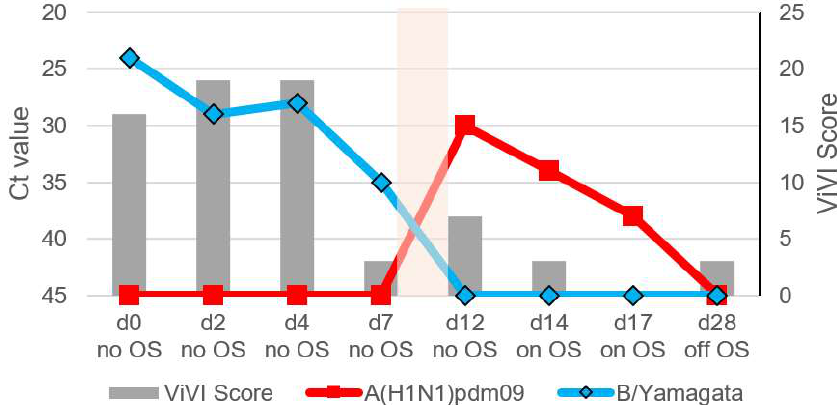
Figure 8. shows Patient 4.2 initially testing positive for B/Yamagata and subsequently A(H1N1)pdm09. The shaded area in beige indicates the time frame of presumed dual infection (in between 2 visits). See virus load as approximated by Ct values on the left inverted vertical axis and ViVI Scores reflecting disease severity on the right vertical axis. “No OS” indicates “no treatment with oseltamivir”, “on OS” indicates “on treatment with oseltamivir”, and “off OS” “discontinuation of oseltamivir treatment”.